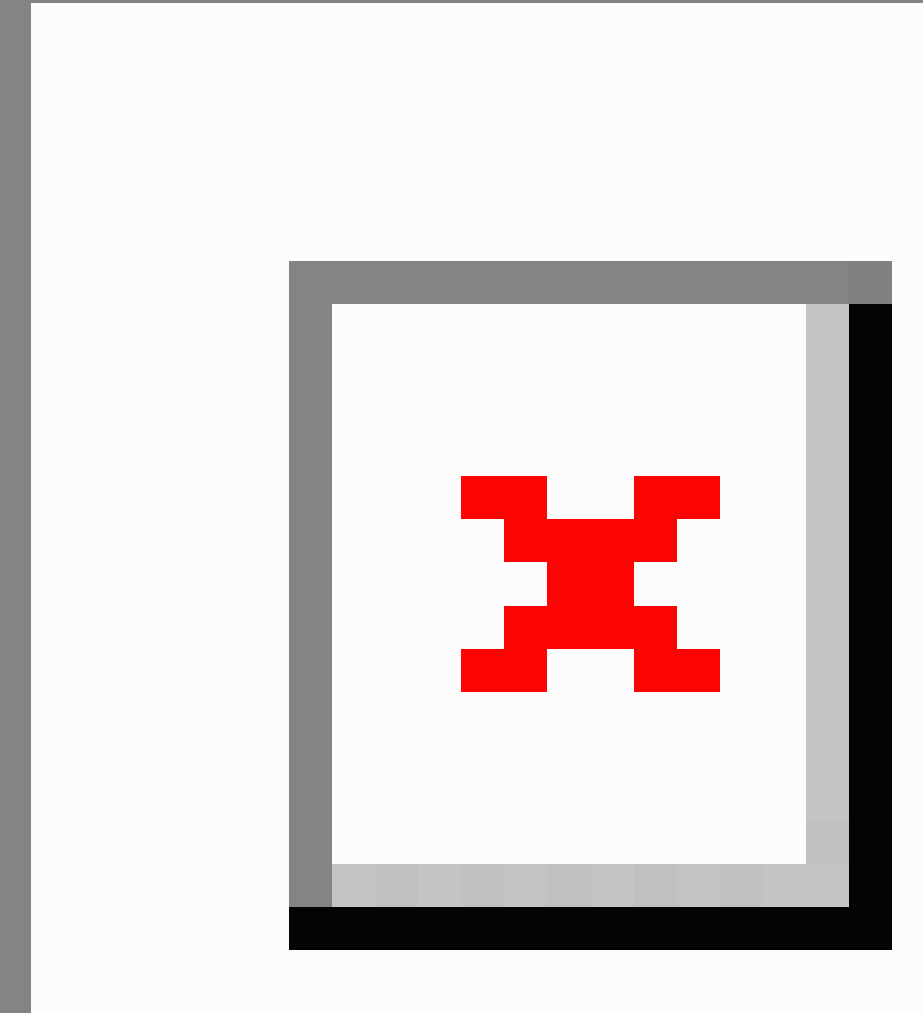
Figure 2. Methodology of